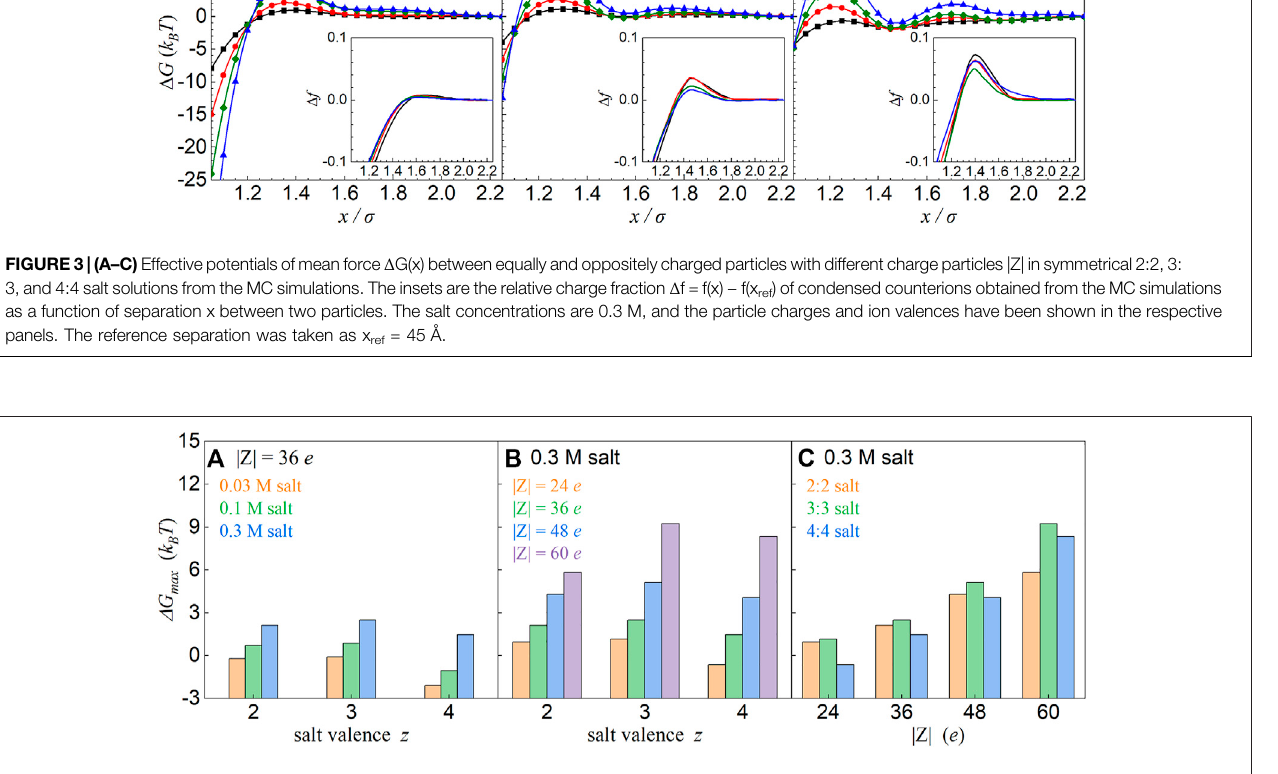
FIGURE4| Relationship betweenthemaximumvalues Δ G max andionvalence z (A,B) andparticlecharge|Z| (C) . Δ G max denotesthe(local)maximumvaluesinthe effective PMF pro fi les. The salt concentrations, particle charges, and ion valences have been shown in the respective panels. Here, the values for 1:1 salts were not shown since there is no effective (local) repulsion for 1:1 salt over the covered salt